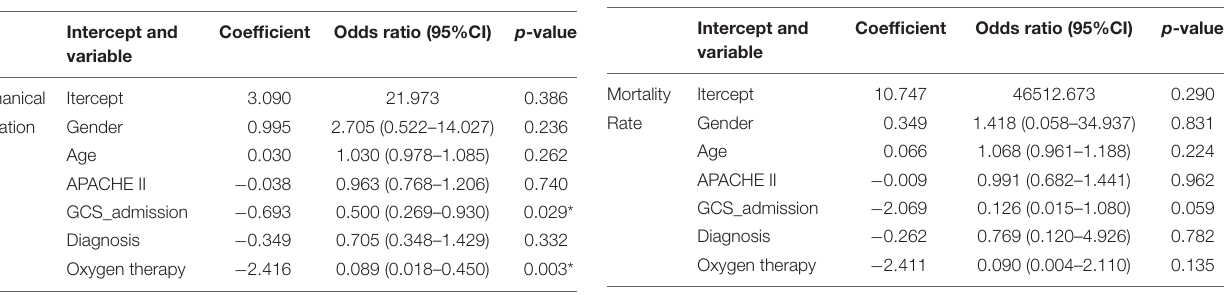
TABLE 7 | Logistics regression analysis of mortality